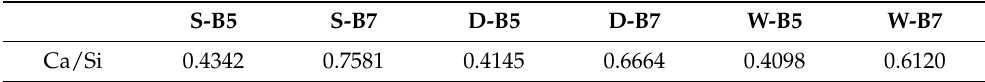
Table 5. Average Ca/Si ratio of geopolymer by EDS analysis.